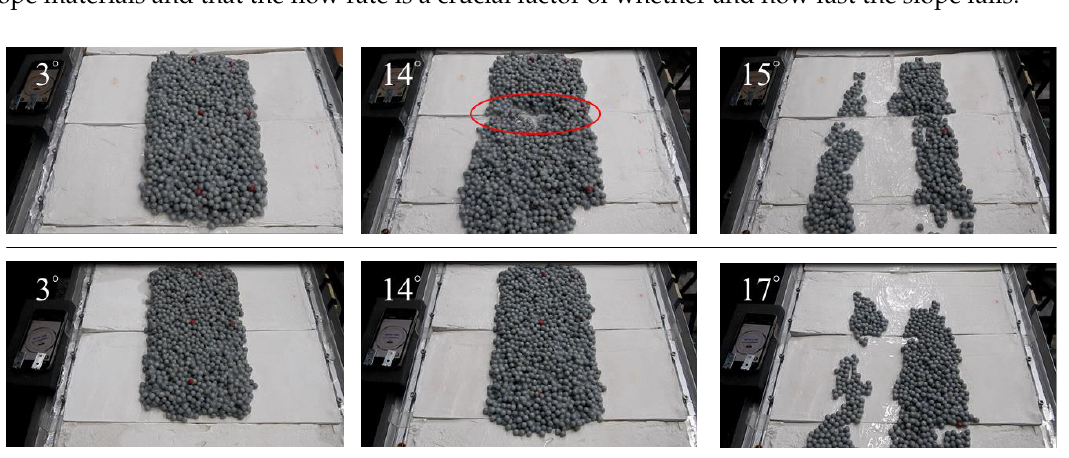
Figure 11. Results of Model 2 (top; top, middle, bottom valves open) and Model 3 (bottom; top valve open).